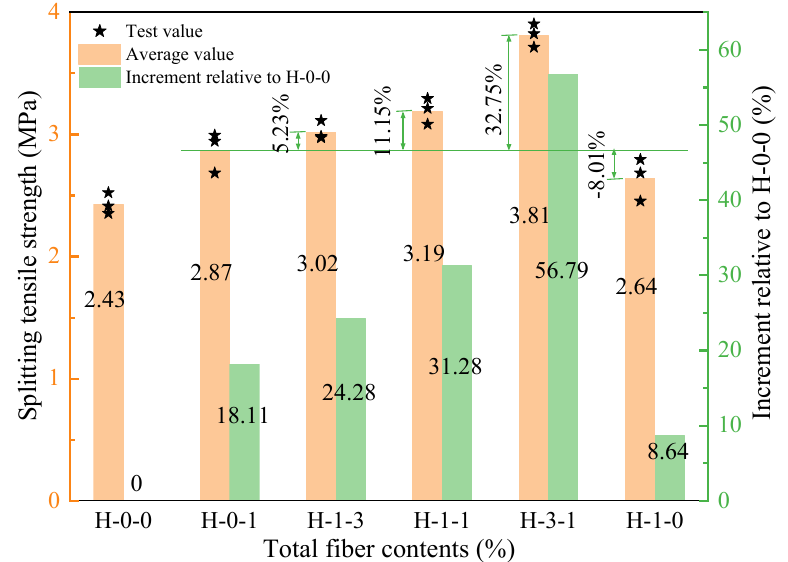
Figure 8. Splitting tensile strength of LHPCC with different fiber hybrid proportions.